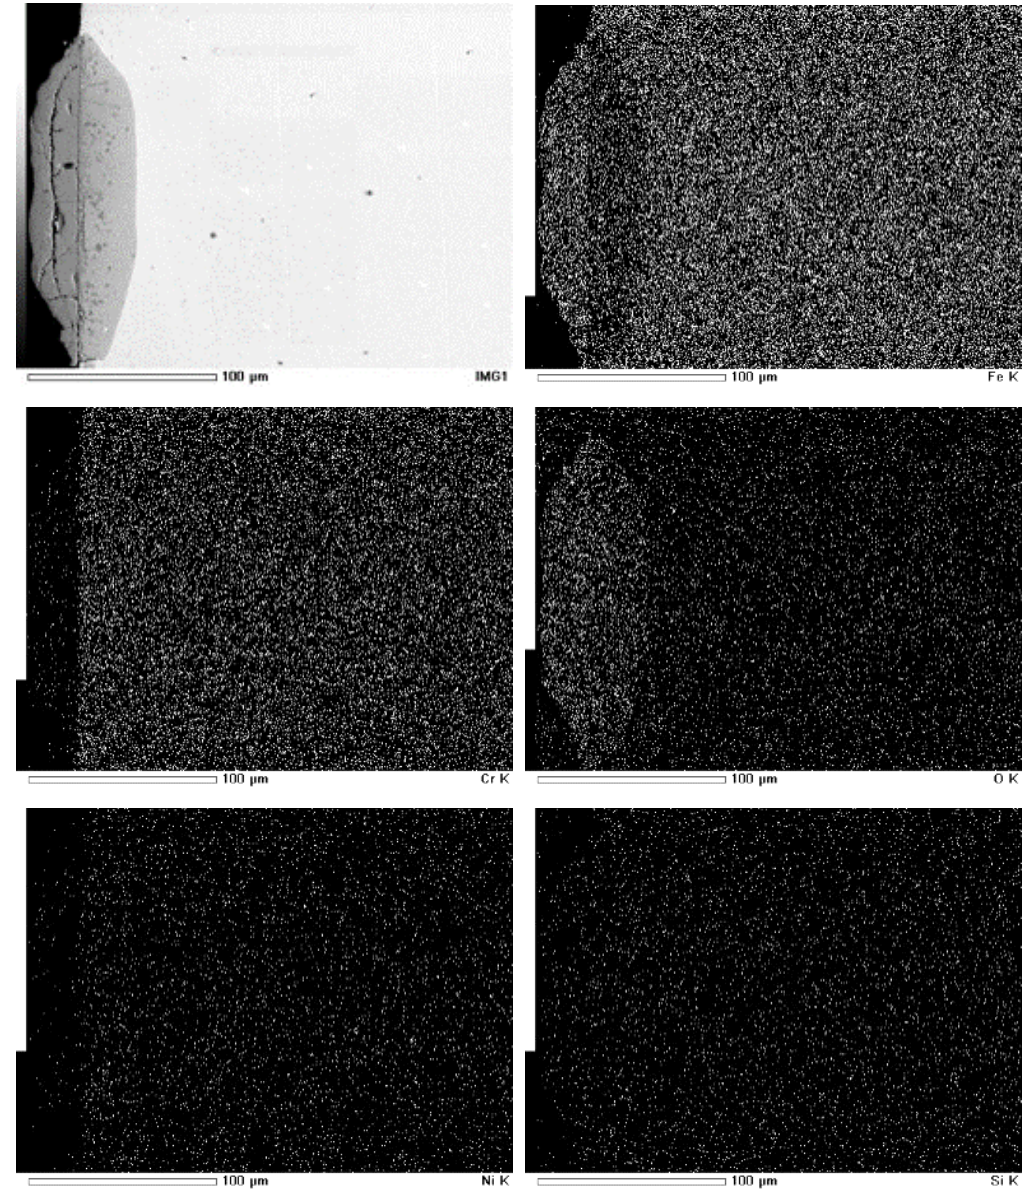
Figure 10. Cross-sectional morphology and elemental mapping of TP347H at 700 ◦ C.